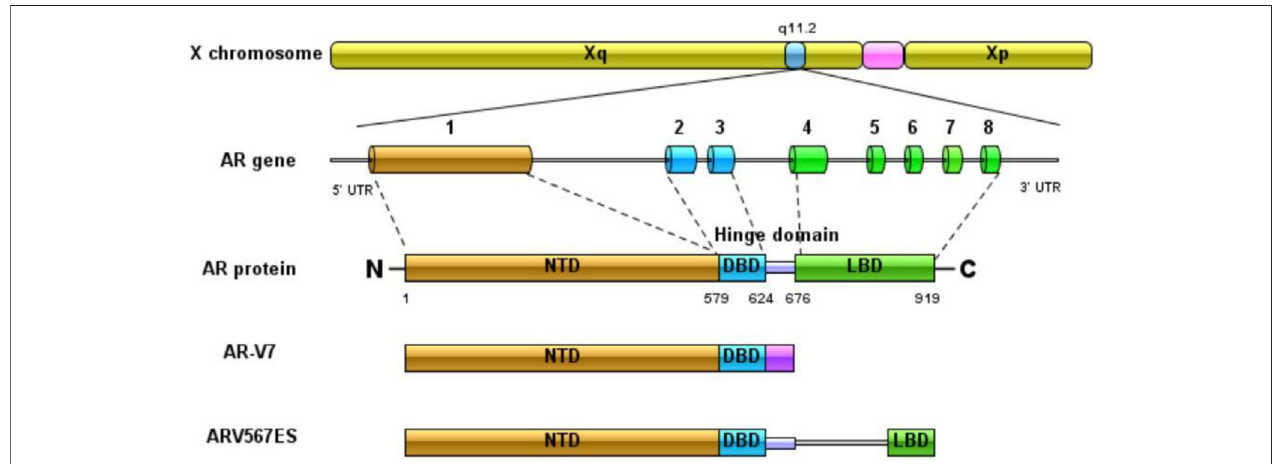
FIGURE 2 | The transcriptional structure of full-length AR and major splicing variants AR-V7 and ARV567ES.